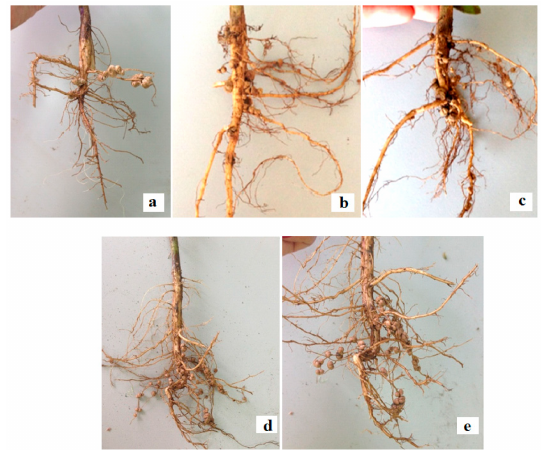
Figure 2. Development of the root system and symbiotic apparatus of soybean plants upon treatment with Ag NPs dispersions: ( a ) Control, N 0 P 0 , no treatment with Ag-PHMB dispersion; ( b ) background (N 30 P 40 ), no treatment with Ag-PHMB dispersion; ( c ) background, Ag-PHMB dispersion—seed treatment 25 mL/t + double plant spraying (V3 and R1 phases) 40 mL/ha; ( d ) background, Ag- PHMB dispersion—seed treatment 50 mL/t + double plant spraying (V3 and R1 phases) 80 mL/ha; ( e ) background, Ag-PHMB dispersion—seed treatment 75 mL/t + double plant spraying (V3 and R1 phases) 120